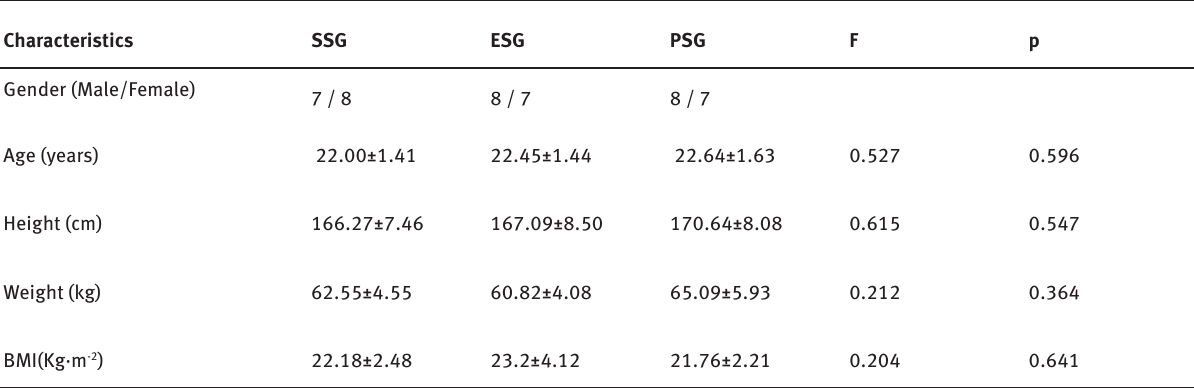
Table 1: General characteristics of the subjects